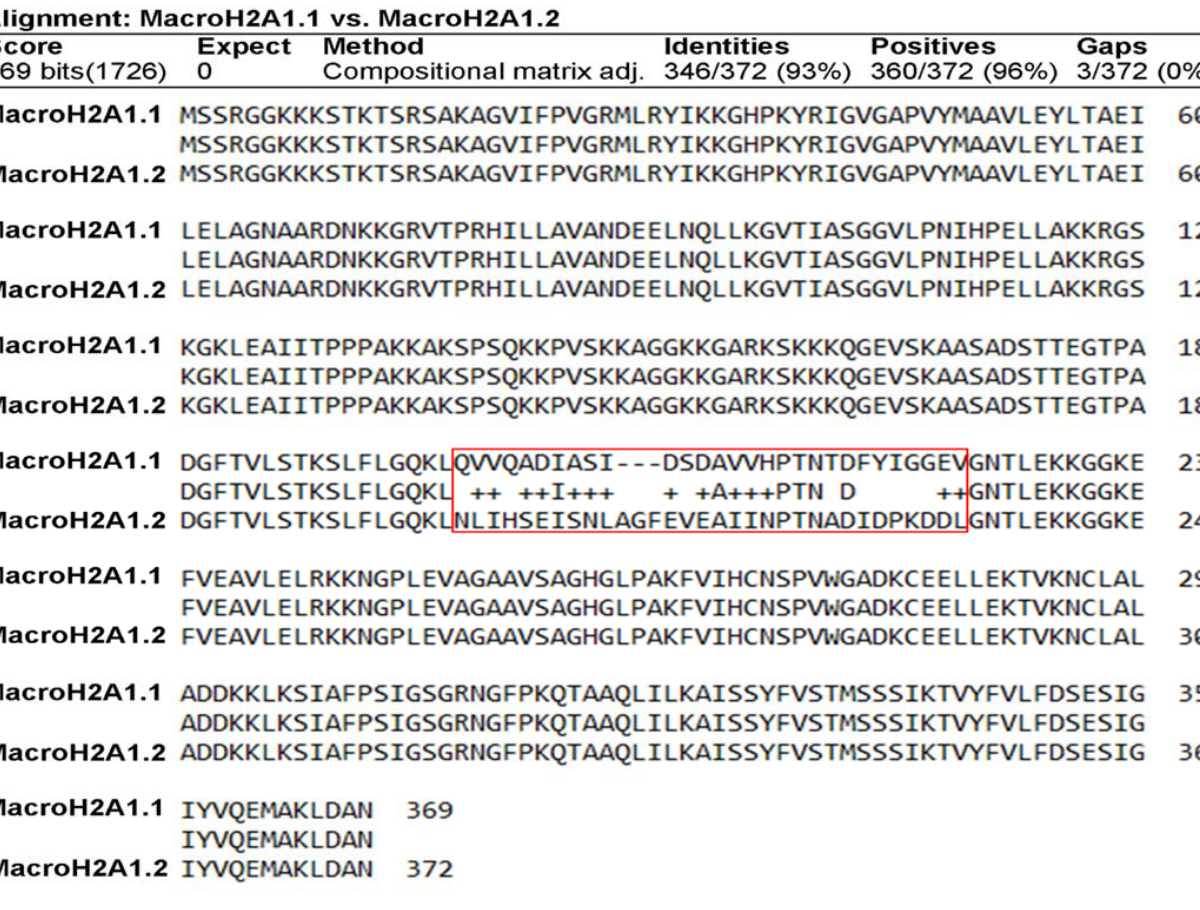
Figure 1. Sequence alignments of macroH2A1.1 versus macroH2A1.2 (human). Local alignment of the sequences of macroH2A1.1 and macroH2A1.2 performed with BlastP.